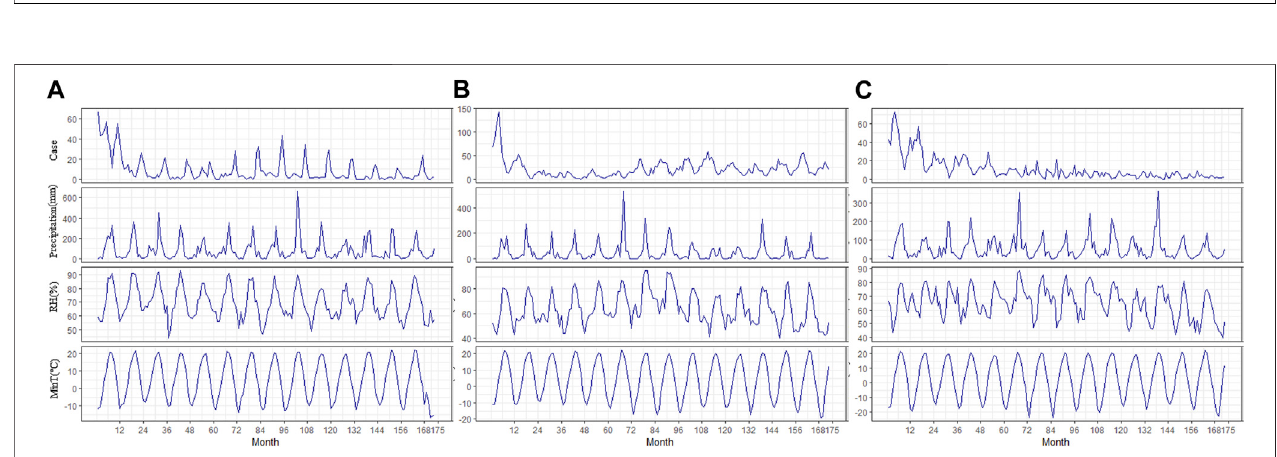
FIGURE 2 | Time series of HFRS cases and meteorological factors in the study areas from 2005-2019. [ (A) : Dandong; (B) : Huludao; (C) : Shenyang].